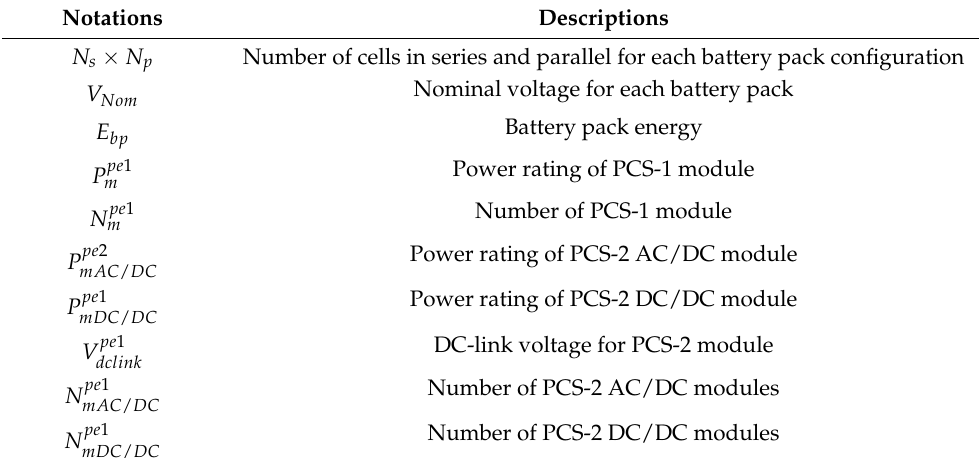
Table 1. Notations used to define the size of HBESS.